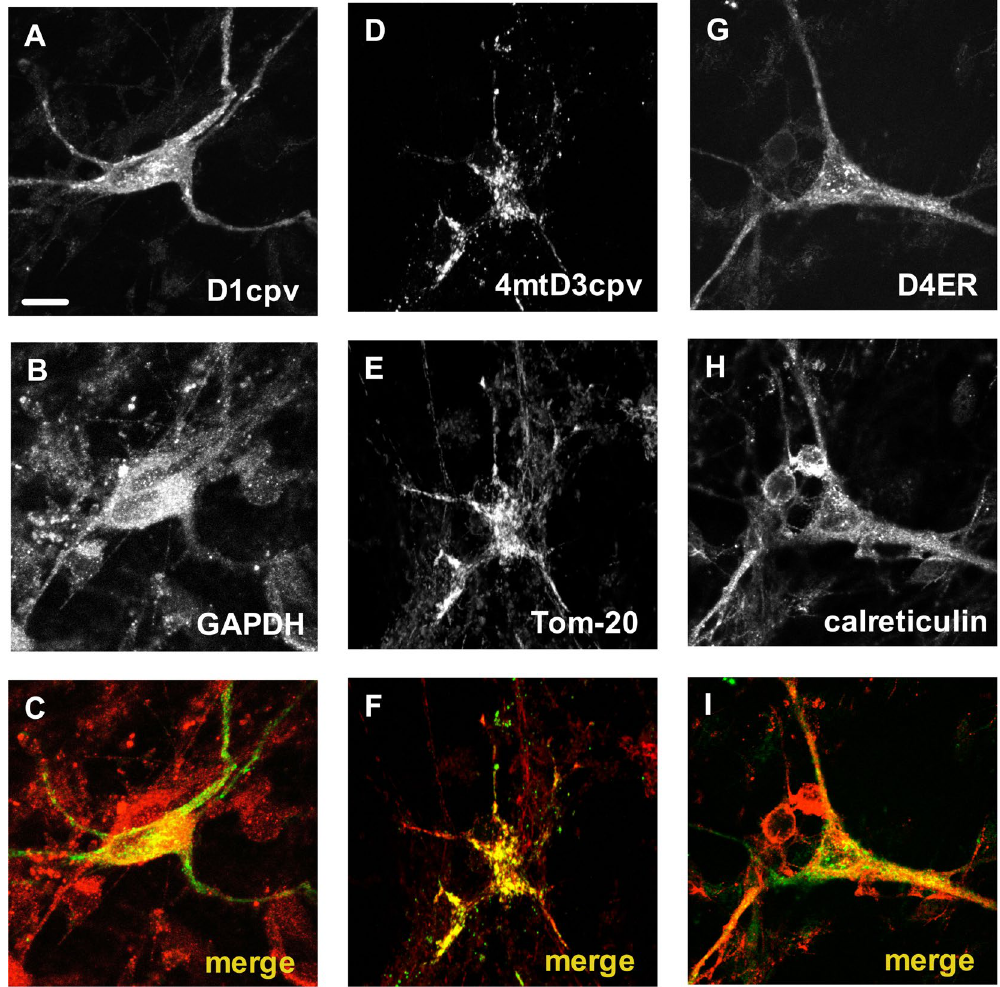
Figure 3. The cameleon probes correctly localize to the target sub-cellular compartment in primary MNs. Primary cell cultures from the mouse spinal cord were transduced with the AAV vectors coding for the cameleons targeted to the cytosol (panels A–C), the mitochondrial matrix (panels D–F) or the ER lumen (panels G–I). After 12 days of culturing, cells were fixed, permeabilised, and immunostained with antibodies to proteins present in the cytosol (GAPDH, panel B), mitochondria (Tom-20, panel E), or the ER (calreticulin, panel H). Images report the merged reconstruction of complete z-stacks of cells, collected by a confocal microscope after excitation at either λ = 488 nm for visualising the fluorescent Ca 2 + probes (panels A,D,G), or λ = 543 nm for visualising the immuno-labeled proteins (panels B,E,H). The remarkable fluorescence overlapping of each targeted cameleon and the corresponding marker immunosignal (panels C,F,I) demonstrates the correct sub- cellular targeting of all used Ca 2 + probes. Scale bar = 10 µ